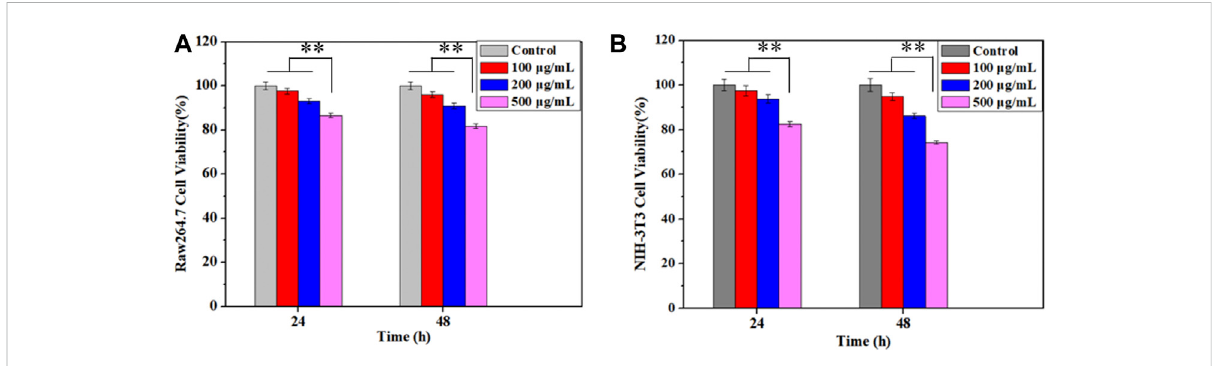
FIGURE 5 Effects of Cur – AceKGM NP concentrations on the proliferation of RAW264.7 (A) and NIH3T3 (B) cells cultured at 24 and 48 h; all the experiments were performed in triplicate and ** p <